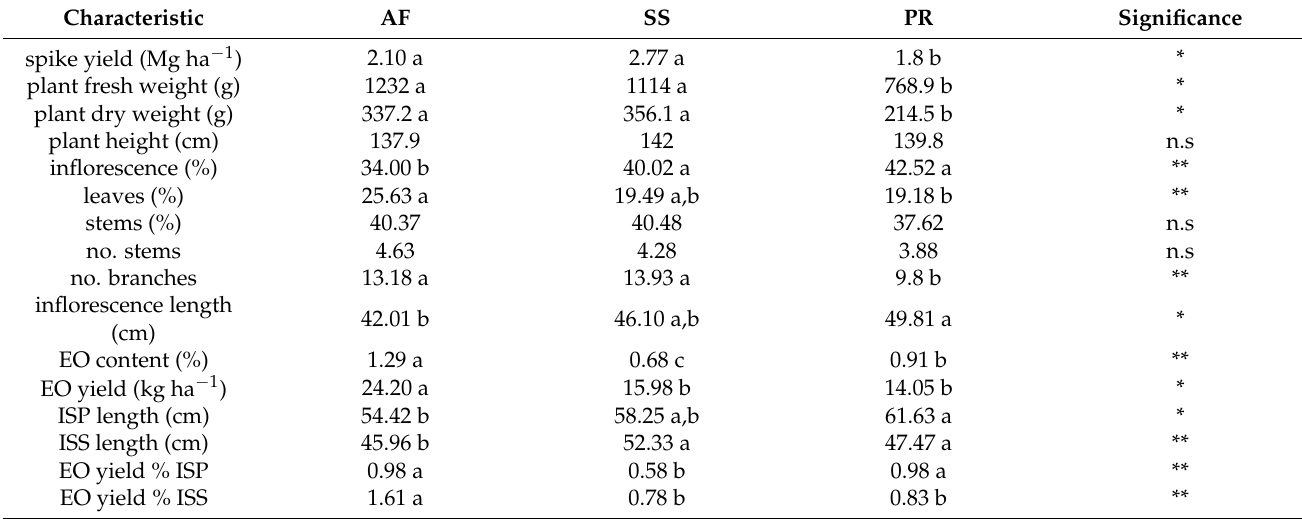
Table 3. Morphological and production characteristics of three LPs (Local Populations) of Salvia sclarea